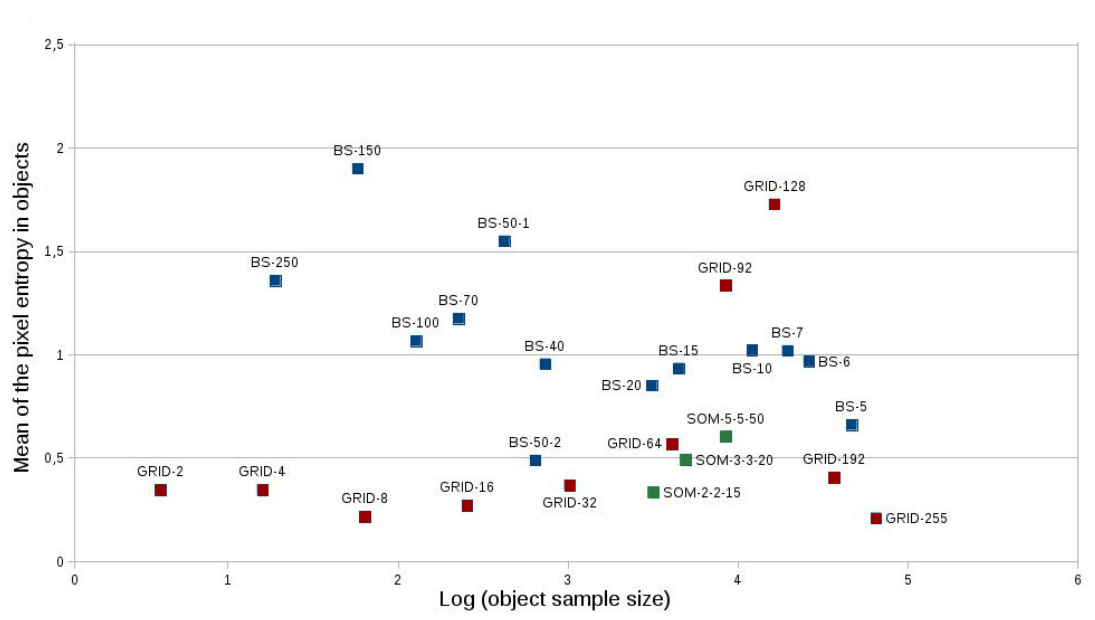
Figure 20. Mean of the pixel value entropy in